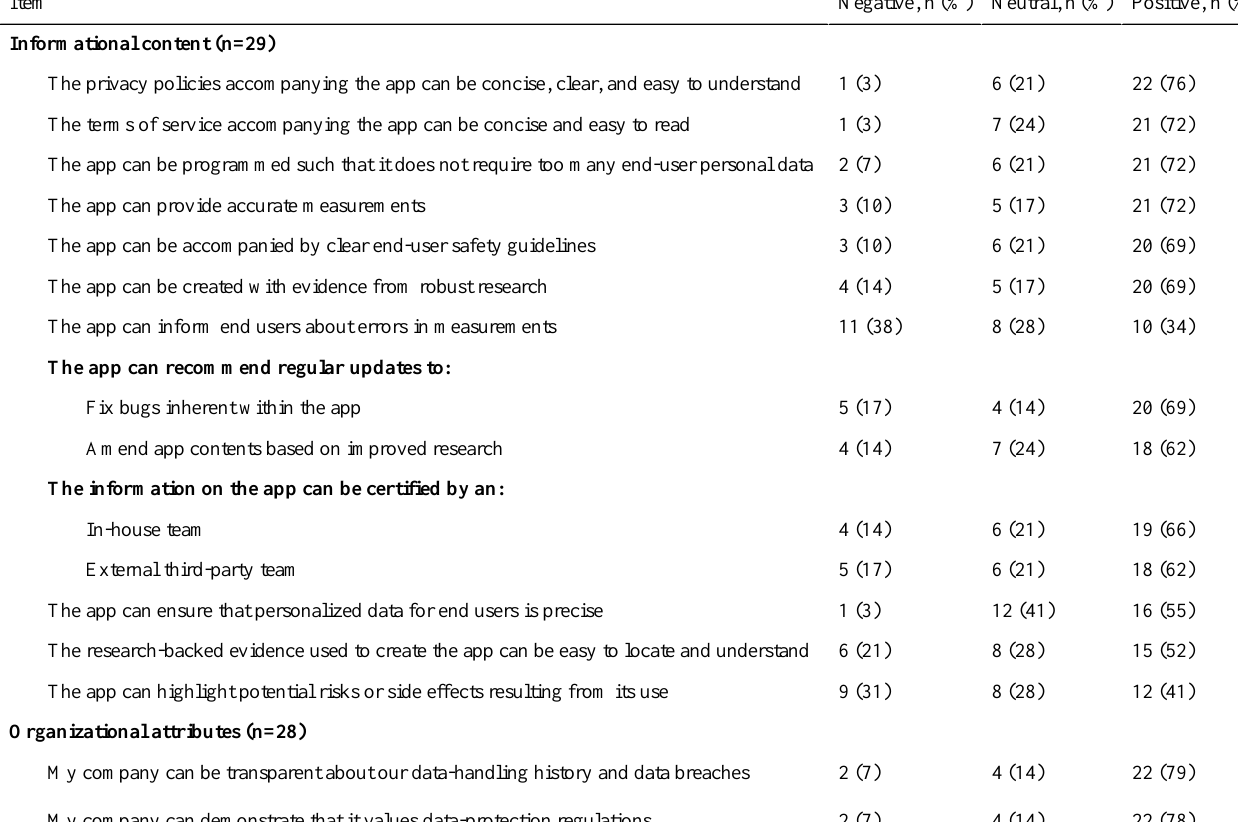
Table 1. Rankings of respondent ratings of checklist